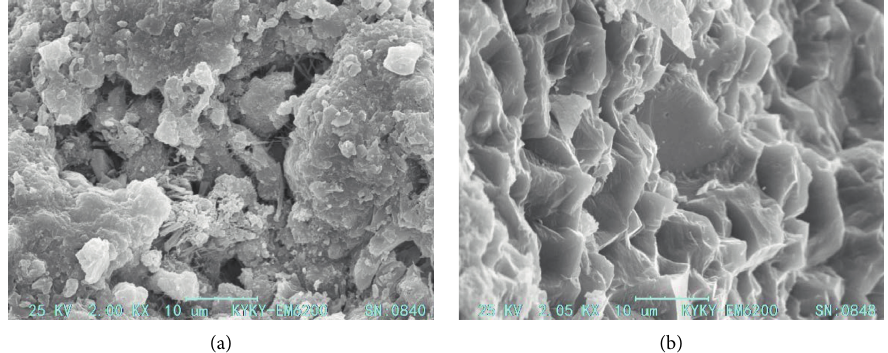
Figure 10: Microstructure of concrete and rock specimens when magnified 2000 times, respectively. (a) Concrete specimen. (b) Rock